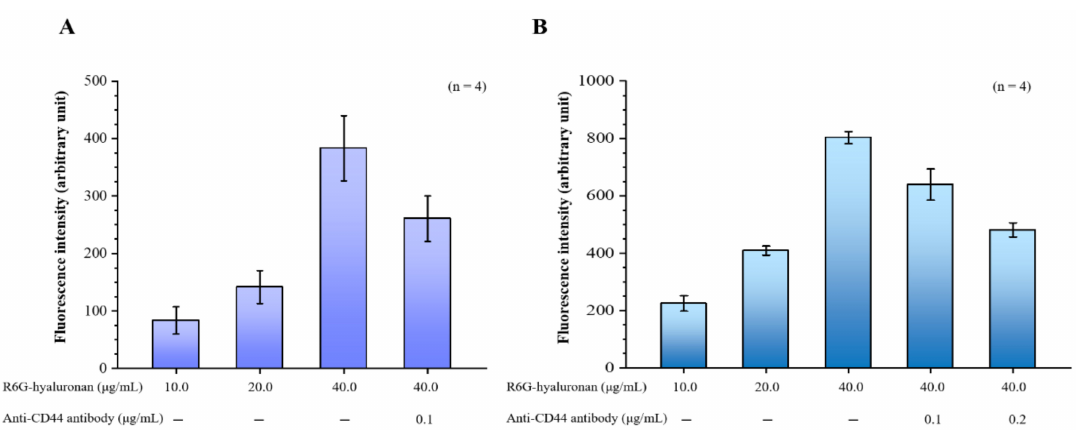
Figure 2. ( A ) Binding assays of fluorescence R6G-hyaluronan to immobilized recombinant CD44; ( B ) Binding assays of macrophages were incubated with fluorescence R6G-hyaluronan. Fluorescence intensities of Rh6G were detected. Data are expressed as means ± SDs ( n = 4).